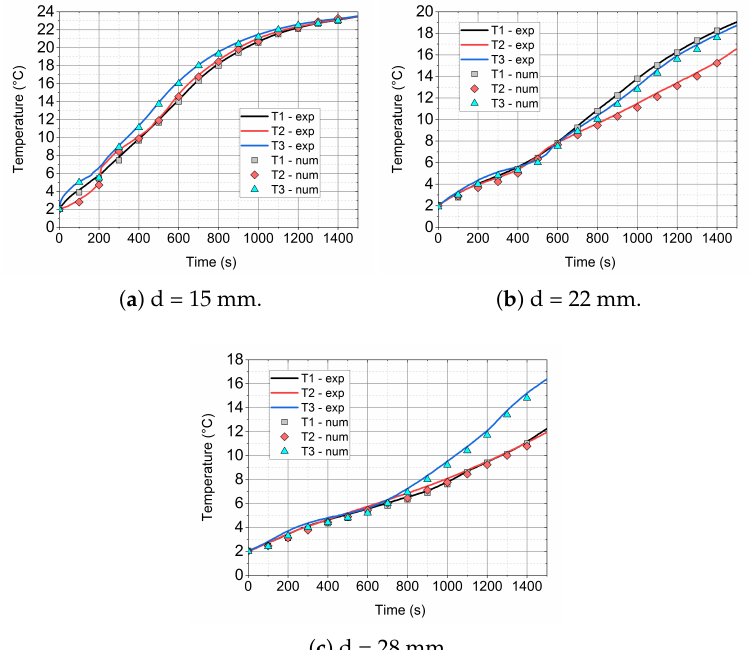
Figure 15. Comparison of the experimental and numerical results for the inlet velocity of 2.27 m/s and different cylinder di-